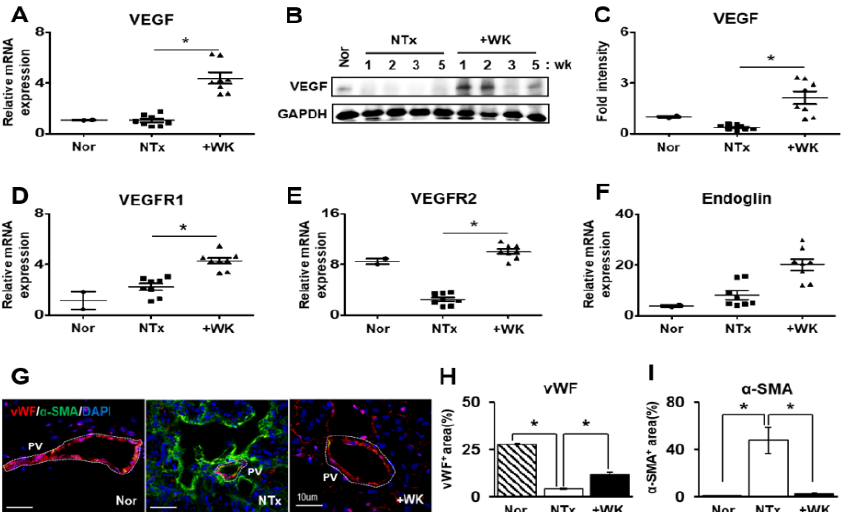
Figure 3. WKYMVm exerts angiogenic effects in the BDL rat liver. ( A – C ) The mRNA and protein levels of vascular endothelial growth factor (VEGF) in the livers of normal, BDL, and WKYMVm-treated BDL rats were analyzed by qRT-PCR and western blot analysis, respectively. The mRNA levels of VEGFR1 ( D ), VEGFR2 ( E ), and Endoglin ( F ) were measured by qRT-PCR. ( G ) Immunofluorescence staining with antibodies against vWF (red) and α -SMA (green). Quantification of vWF ( H )- and α -SMA ( I )-stained cells. Mean ± SD ( n = 3 per group), * p < 0.05; one-way ANOVA. Nor, normal control group; NTx, untreated BDL group; +WK, WKYMVm-treated-BDL group; PV, portal vein; wk, week.